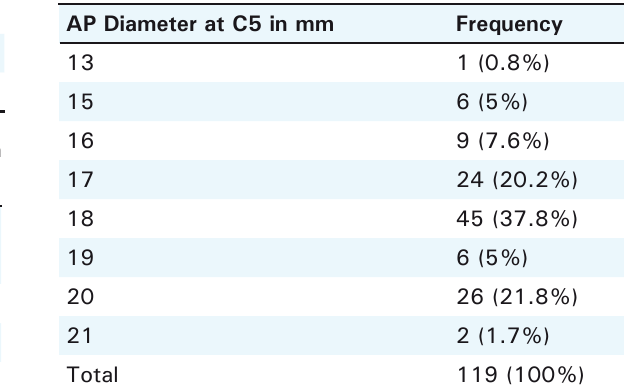
table 5. Showing the AP diameter of spinal canal at C5